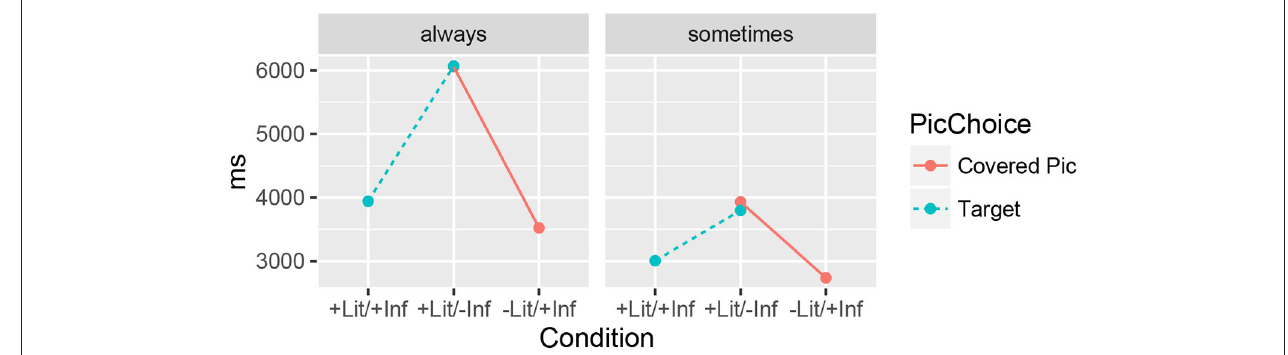
FIGURE 5 | RTs for responses by picture choice and condition. + Lit/ + Inf target choices and + Lit/ − Inf Covered picture choices are taken to reflect inference interpretations, and + Lit/ − Inf target choices and − Lit/ + Inf Covered picture choices no-inference interpretations.